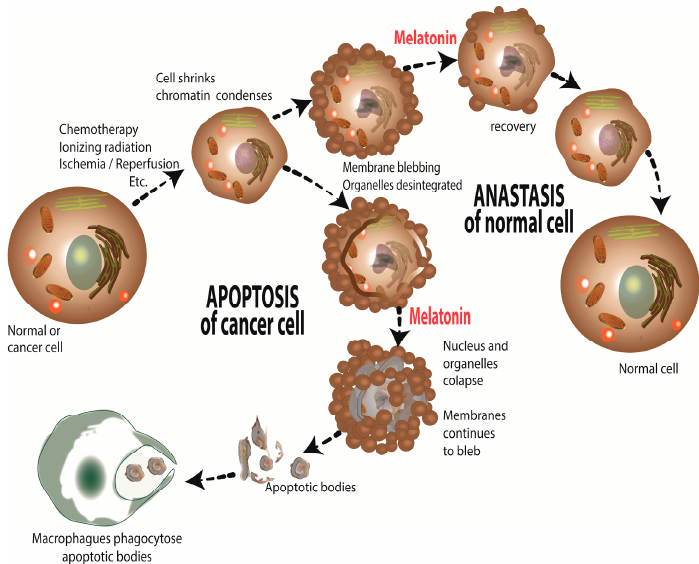
Figure 10. Anastasis, a recently-discovered cellular function, describes the recovery a cell undergoes after apoptosis has been initiated but then the stimulus that launched the apoptosis process is withdrawn. As illustrated here, based on what is known about the context specificity of melatonin’s actions, the function of melatonin on anastasis will differ between normal and cancer cells. Thus, the addition of melatonin to cancer cells at a time that the apoptosis initiates is withdrawn will push the cancer cells along the apoptosis pathway, while under the same treatment, normal cells will be induced to recover more quickly.